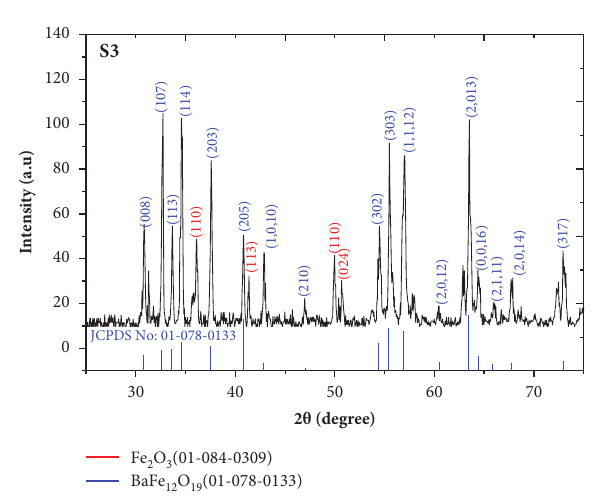
Figure 2: XRD patterns of S